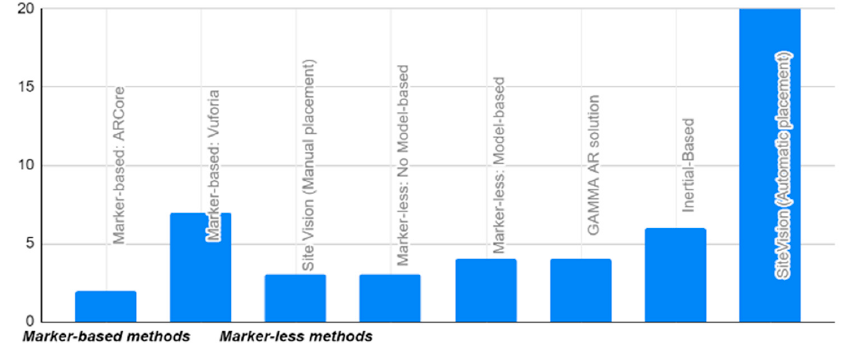
Figure 19. Placement stability of marker-less and markers-based methods.